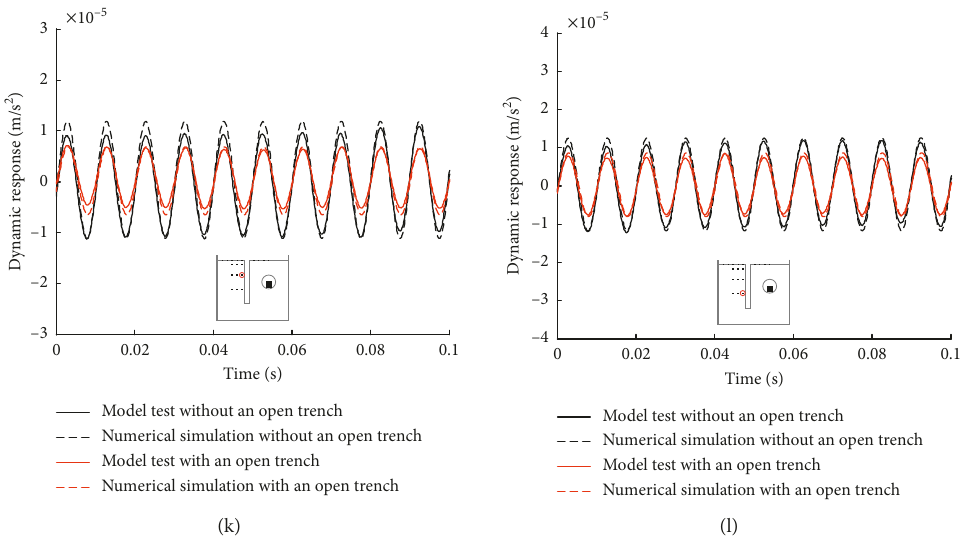
Figure 6: Dynamic response of soils under the action of harmonic loads. (a) 200Hz at point A14. (b) 200Hz at point A13. (c) 200Hz at point A4. (d) 200Hz at point A1. (e) 100Hz at point A14. (f) 100Hz at point A13. (g) 100Hz at point A4. (h) 100Hz at point A1. (i) 50Hz at point A14. (j) 50 Hz at point A13. (k) 50Hz at point A4. (l) 50 Hz at point